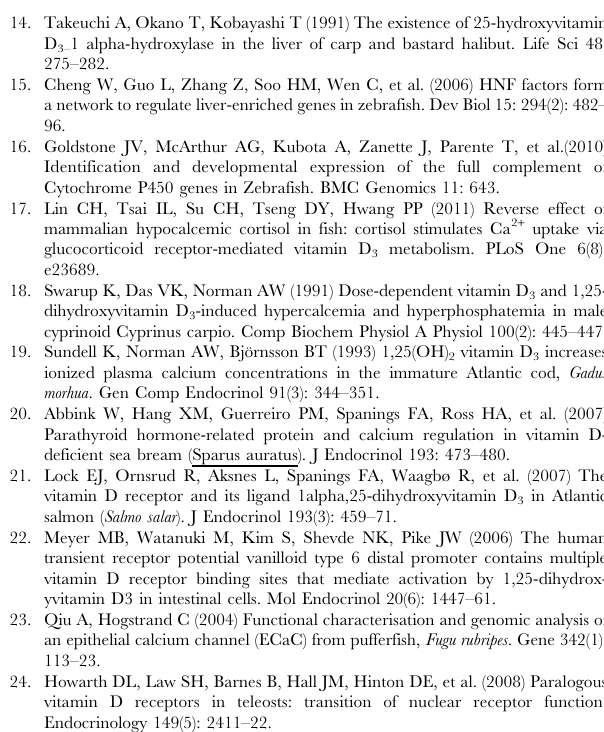
Figure S1 Specificity and effectiveness of vitamin D receptor (VDR)a and VDRb morpholino oligonucleo- tides (MOs). VDRa and VDRb MOs were respectively injected into 1- or 2-cell embryos. To clarify the MO specificity and effectiveness, Western blotting was used to detect VDRa and VDRb protein expressions in wild-type (WT) and MO-injected embryos at 3 d post-fertilization (dpf). An asterisk (*) indicates the position of VDRa or VDRb expression.